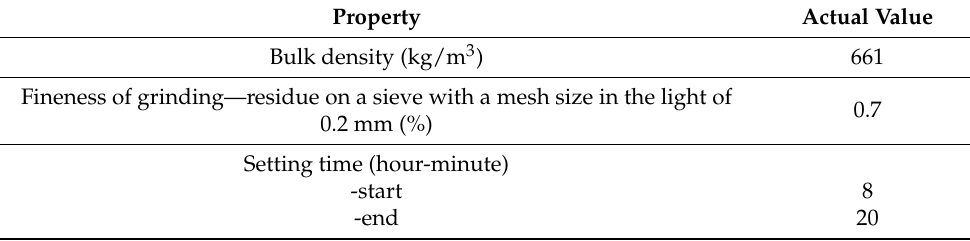
Table 4. Characteristics of gypsum.